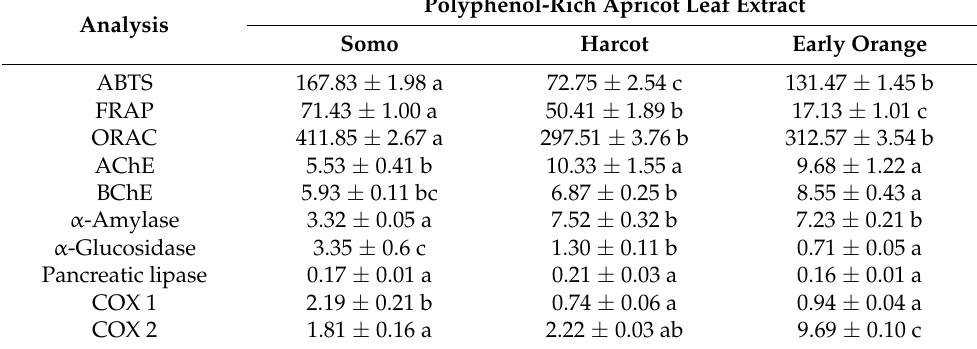
Table 2. Antioxidant capacity (ORAC, FRAP, ABTS; mmol TE/100 g dw), enzymatic in vitro enzyme inhibition of hyperglycemic ( α -glucosidase, α -amylase; IC 50 , mg/mL), obesity (pancreatic lipase; IC 50 , mg/mL), cholinesterase (acetylcholinesterase, butylcholinesterase; %), and inflammatory (COX- 1 and -2; IC 50 , mg/mL) of